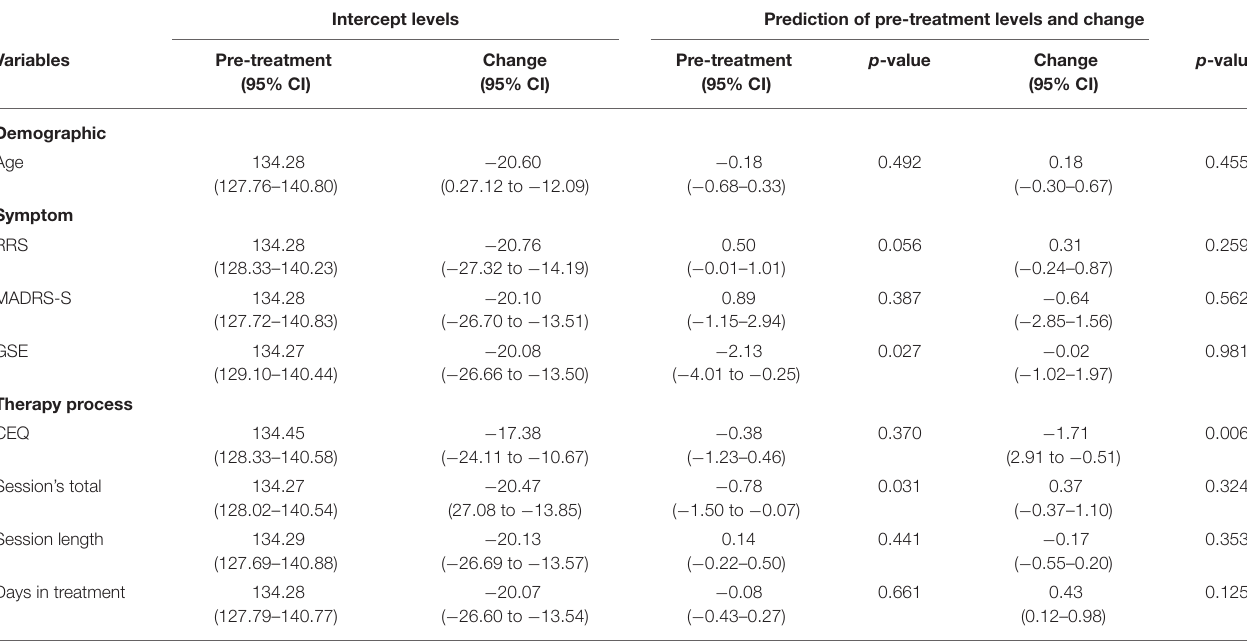
TABLE 3 | Linear mixed model with estimated intercept levels for pre-treatment level and change, pre-treatment levels, and change in residual cognitive symptoms (BRIEF-A GEC) adjusted for continuous demographic, symptom, and therapy process variables ( N = 43). Intercept levels Prediction of pre-treatment levels and